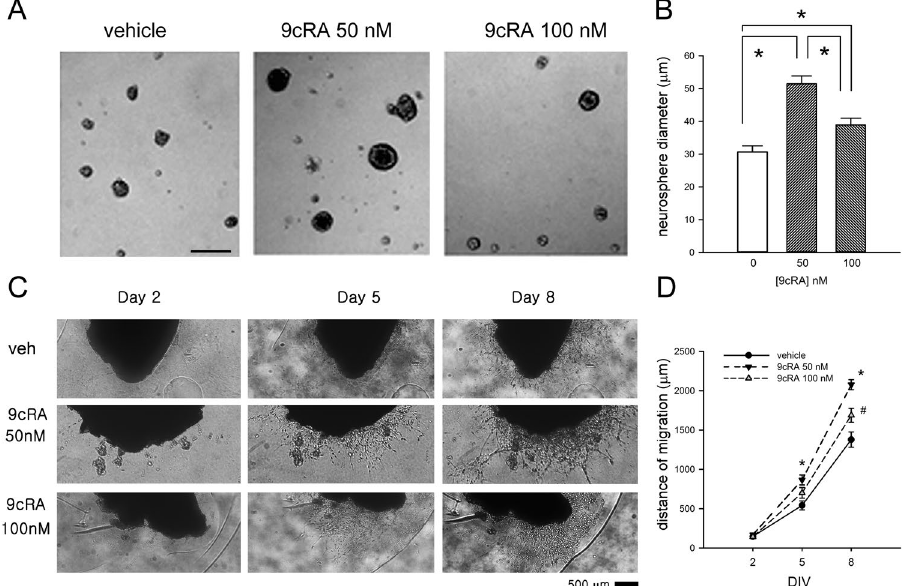
Figure 6. 9cRA increased proliferation and migration of SVZ cells in culture. ( A ) 9cRA increased the diameter of SVZ neurosphere. ( B ) 9cRA, at 50 nM, significantly enhanced diameter of neurosphere ( * p < 0.05, one way ANOVA on Rank + posthoc Dunn’s test). Calibration = 100 µ m. ( C ) The migration of SVZ cells